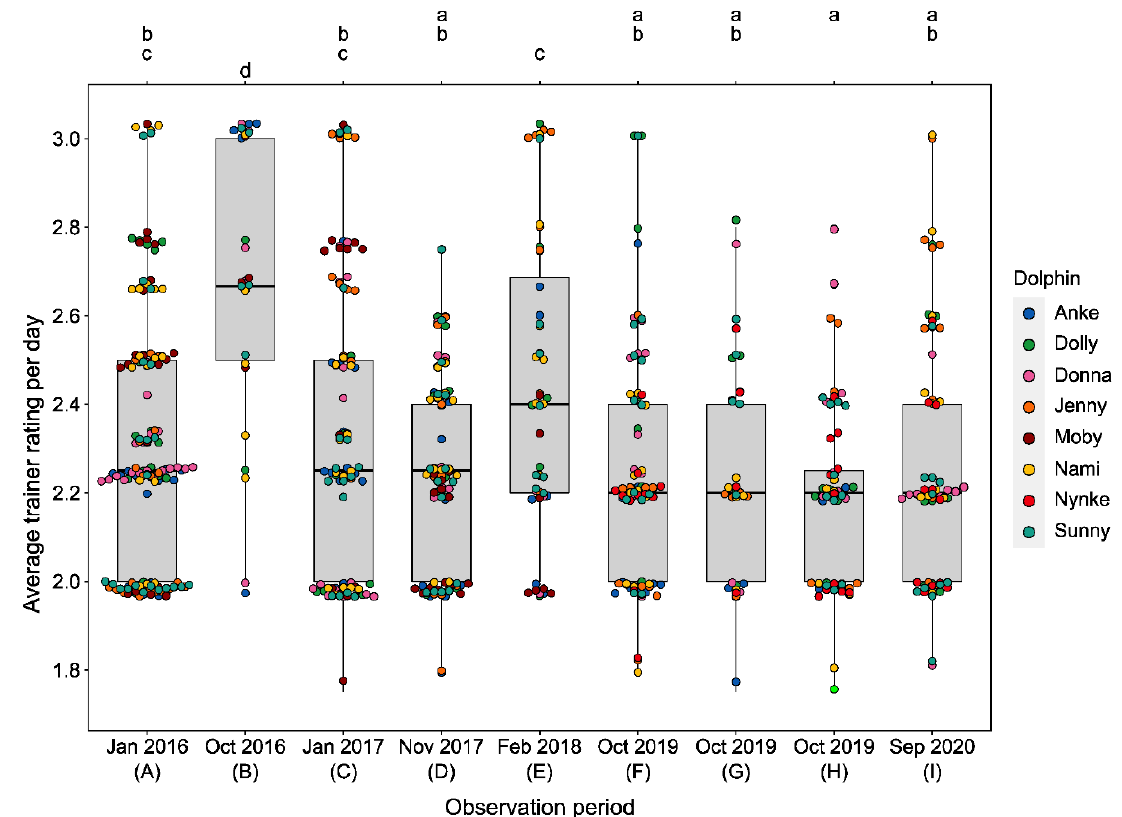
Figure 6. Differences in average training performance evaluated by the trainers after each session for all eight focal dolphins (see Legend) across all observation periods (A–I). Periods sharing a letter are not significantly different (based on Tukey’s post hoc test, p < 0.01).